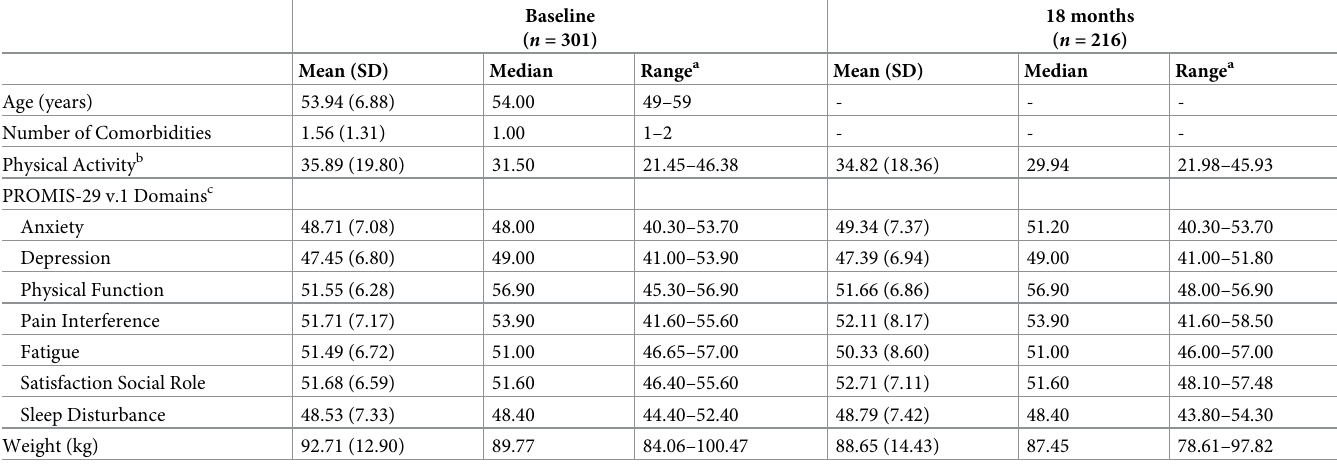
Table 1. Descriptive statistics of demographic characteristics, physical activity, PROMIS-29 v.1 variables, and weight at baseline and 18 months.